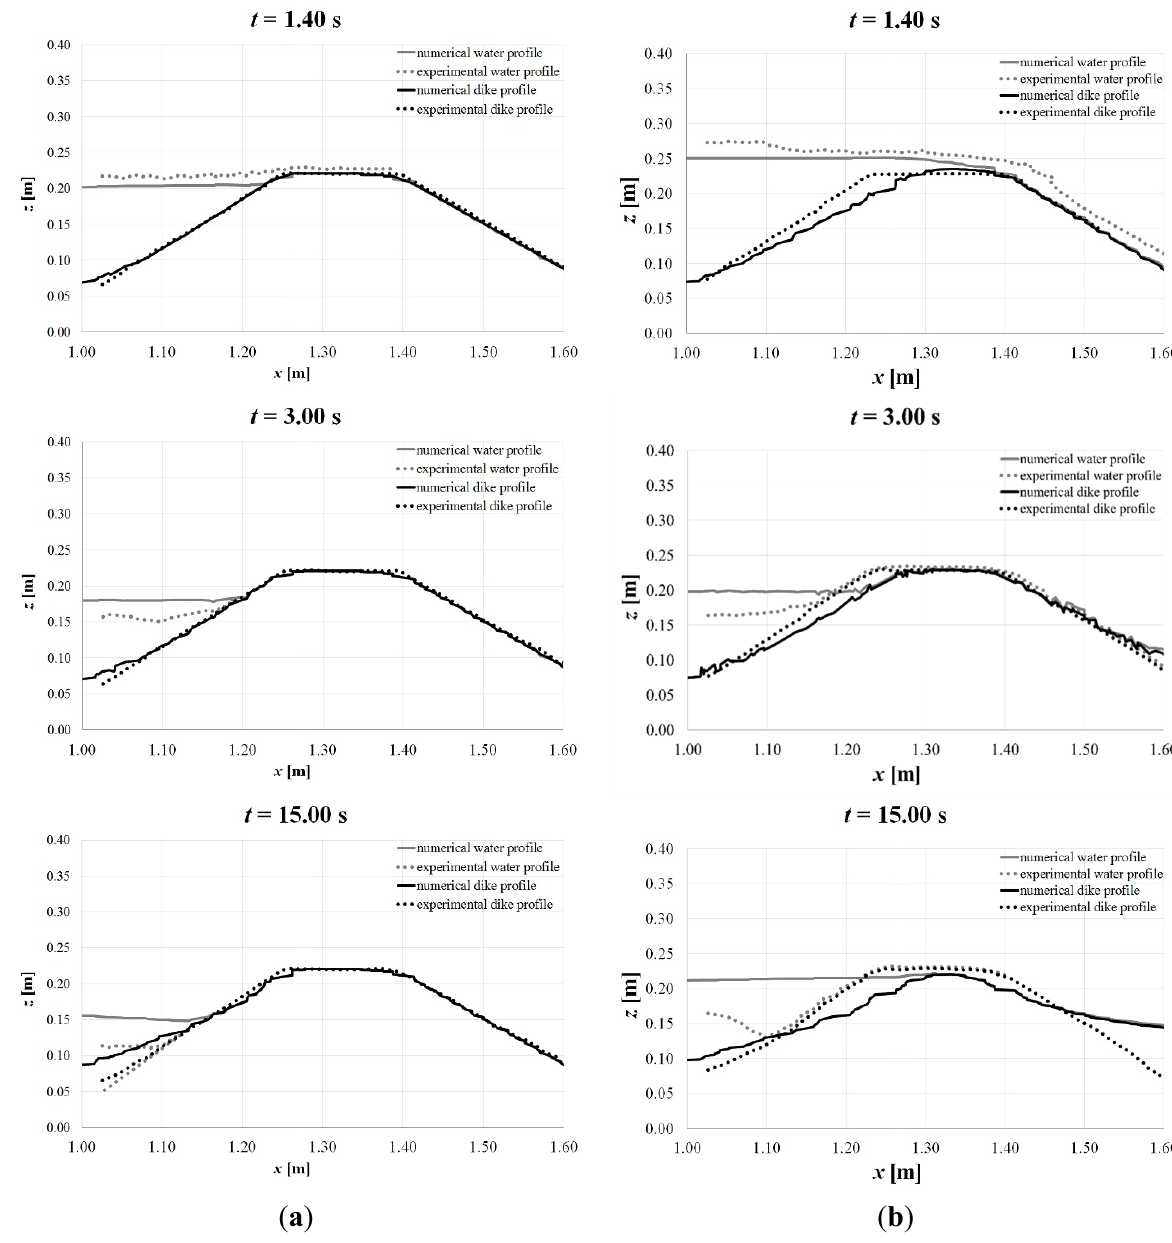
Figure 10. Comparison of the experimental results (dotted lines) against the numerical ones (solid lines) for Test A1 ( a ) and Test A2 ( b ), respectively: water (grey) and dike (black) profiles at times t = 1.40, 3.00 and 15.00 s,